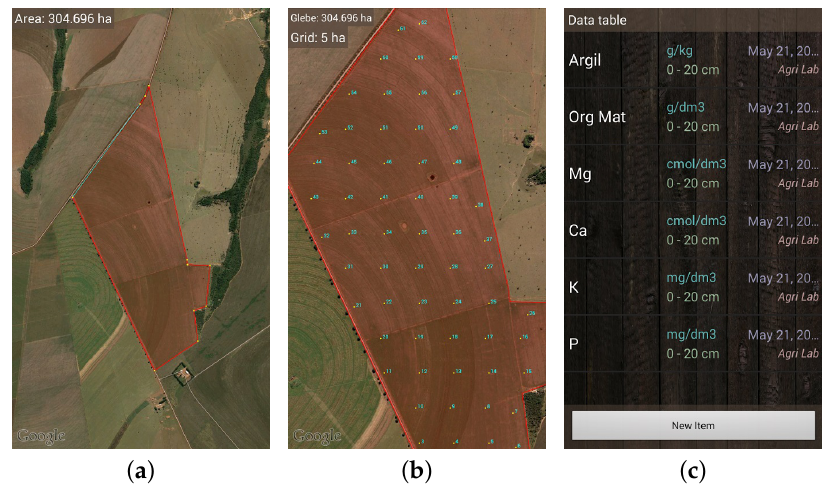
Figure 31. Agri Precision: ( a ) Visualizing filed area; ( b ) Visualizing sample grid; ( c ) Visualizing data table.